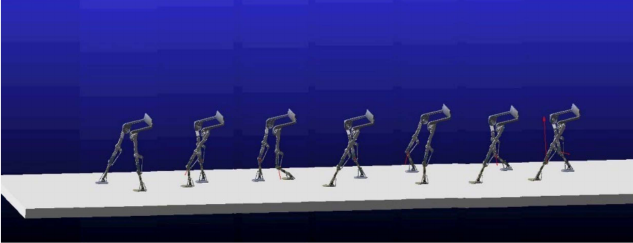
Figure 20. Dynamic analysis of lower-limb exoskeleton robot.